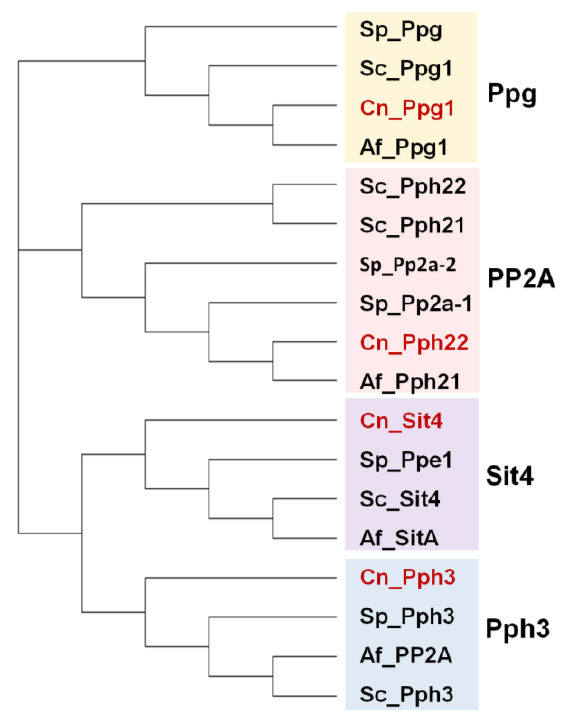
FIGURE 4: Phylogenetic tree of PP2A and PP2A-like phosphatases from various fungal species. Protein sequences correspond to organisms described in the Figure 2. The analysis was performed as described in Figure